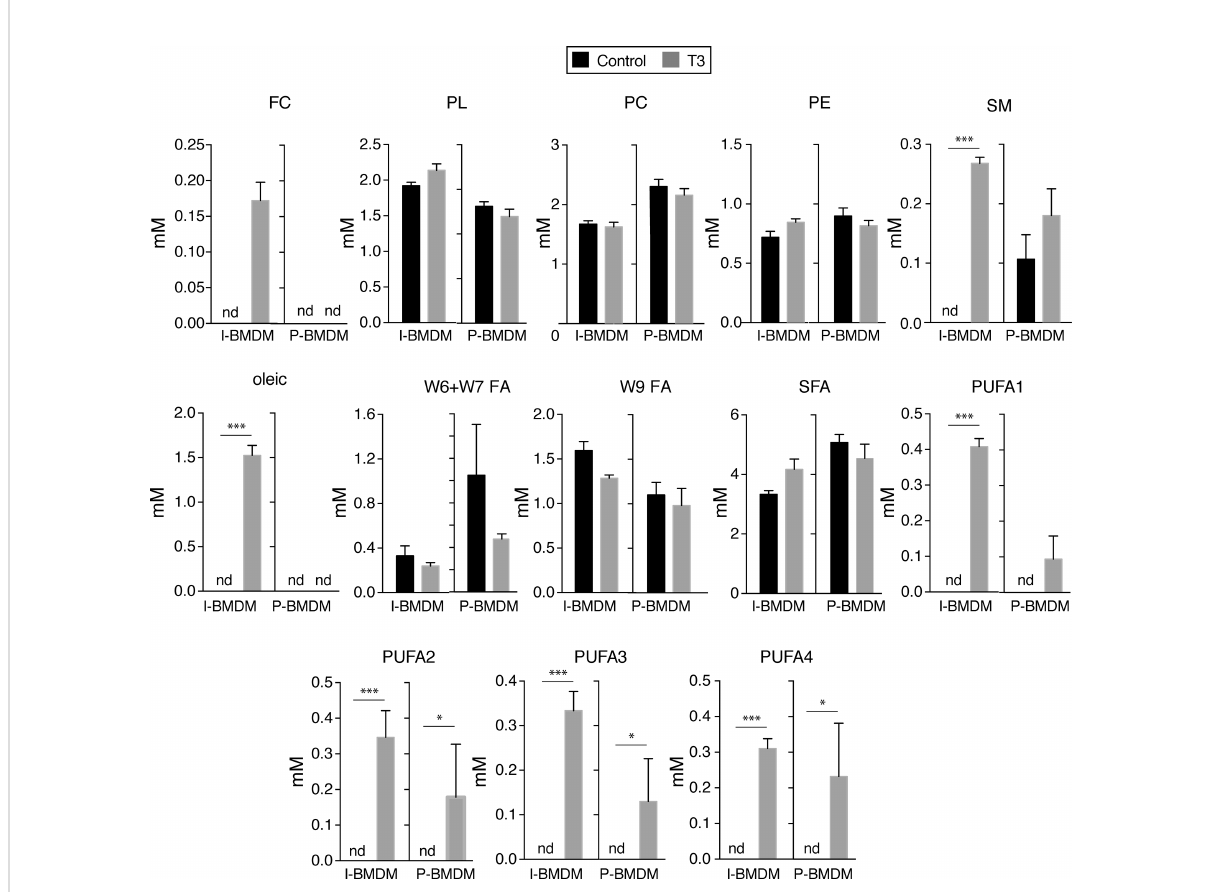
FIGURE 5 T3 increases the levels of polyunsaturated fatty acids in immortalized and primary macrophages. Concentration of lipid metabolites in the same cells of Figure 4 are shown. FC, free cholesterol, PL, phospholipids, PC, phosphatidylcholine, PE, phosphatidylethanolamine, SM, sphingomyelin, FA, fatty acids, SFA, saturated fatty acids, PUFA, polyunsaturated fatty acids. A chi squared test was performed to evaluate a differential presence of lipid families between control and T3-treated cells when metabolites were not detected (nd) in one group. *p < 0.05; ***p <